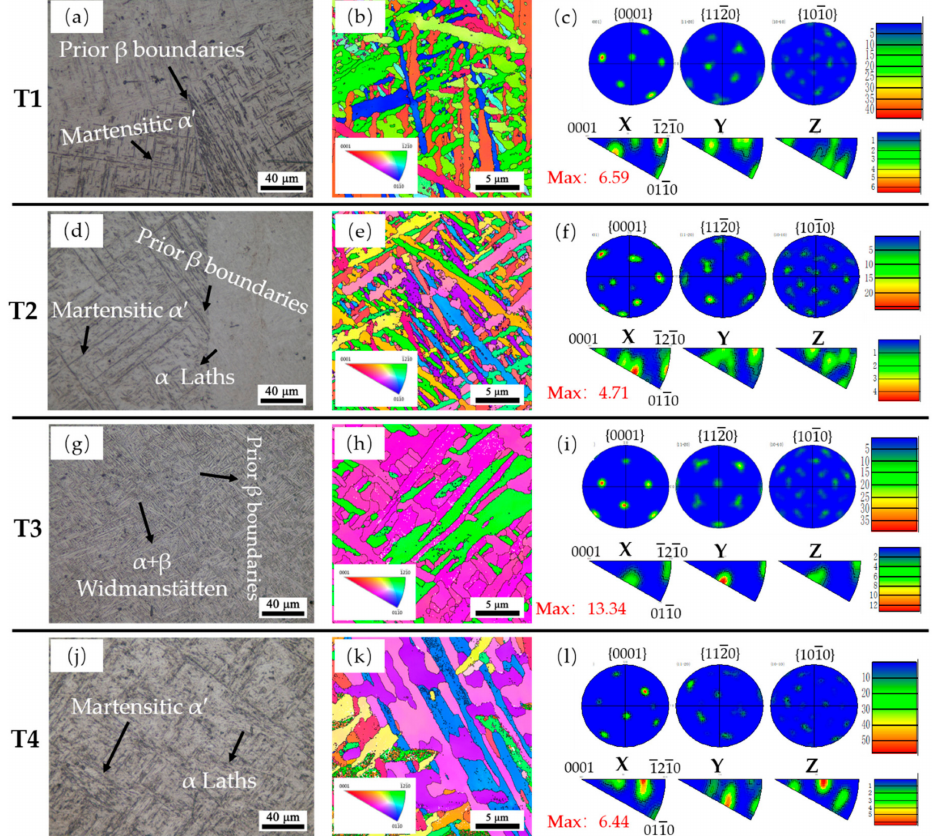
Figure 11. The specific micro-structures of the four samples and the texture examination results. ( a,d,g,j ) micro-structure features for T1, T2, T3, and T4, respectively. ( b,e,h,k ) The EBSD inverse pole figure maps and ( c,f,i,l ) corresponding pole and inverse pole